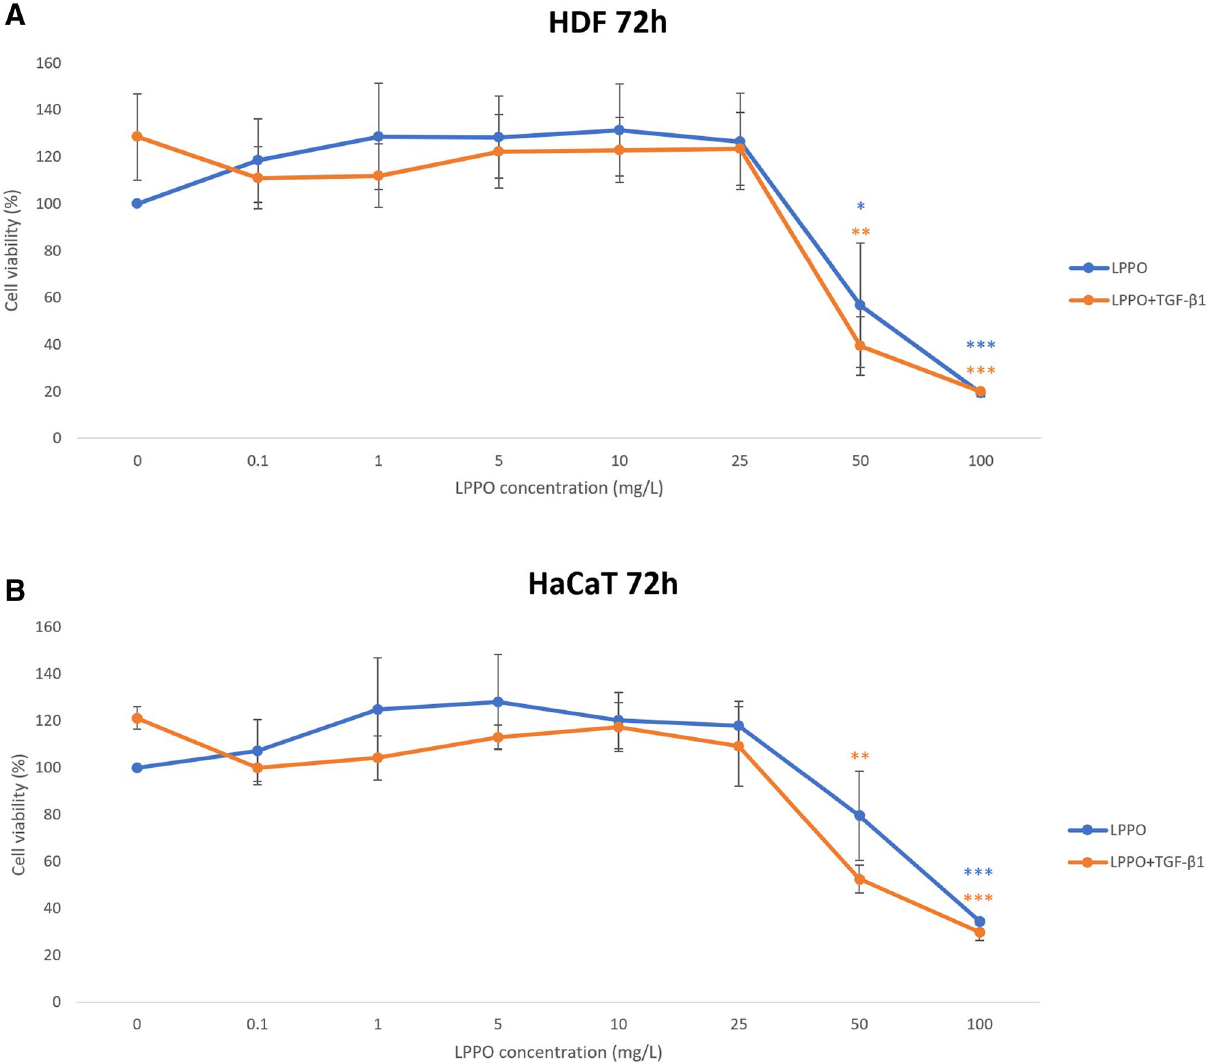
Figure 3. MTS-assay of human dermal fibroblasts (HDFs) ( A ) and HaCaT keratinocytes ( B ) cultured in the presence of LPPO and/or TGF-β1 (30 ng/mL) for 72 h (* p < 0.05; ** p < 0.01; *** p <